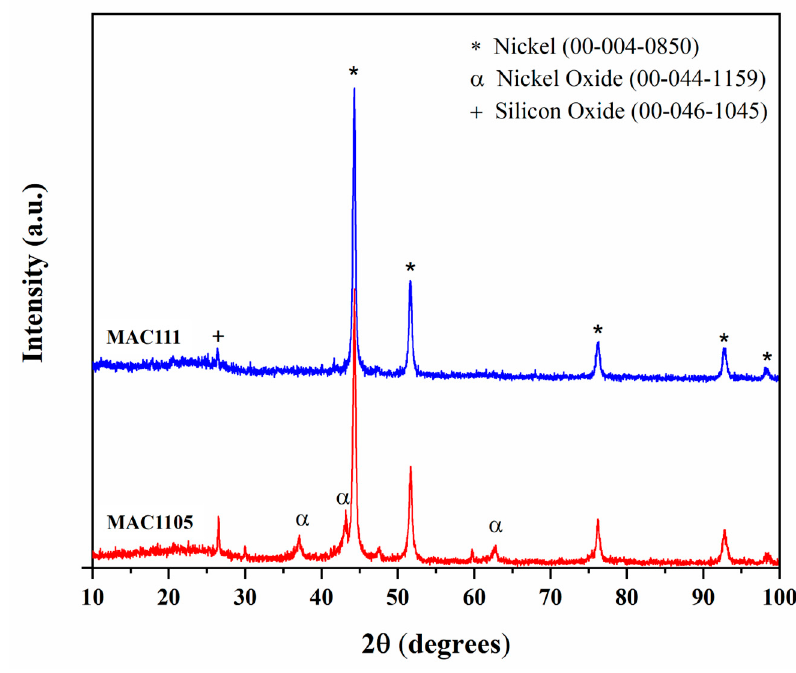
Figure 5. XRD patterns of MAC1105 and MAC111.